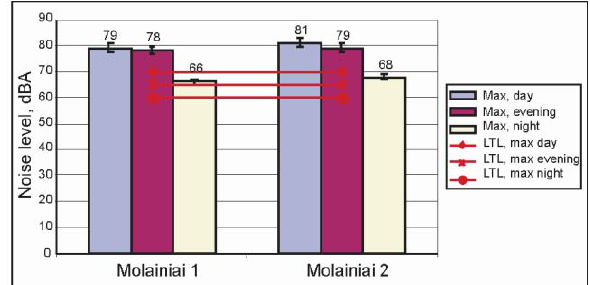
Fig. 11. Dynamics of maximum noise levels in Molainiai street within twenty four hours